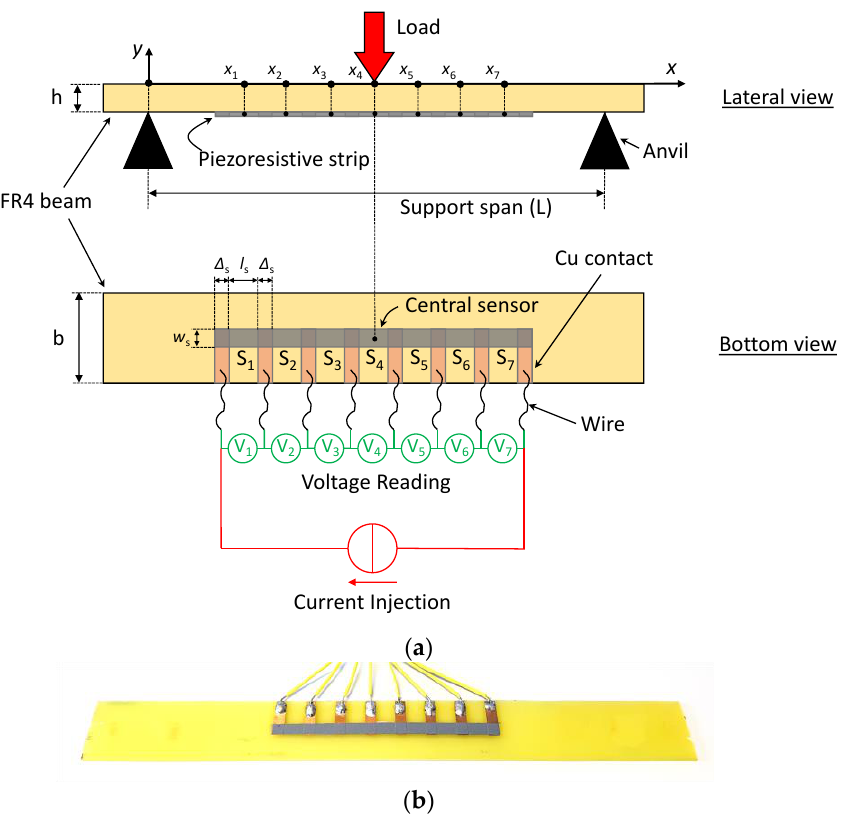
Figure 5. Sketch of the FR4 beam with a 1D array of seven GNP/PU painted sensors for three-point flexural tests ( a ); picture of the sample ( b ).